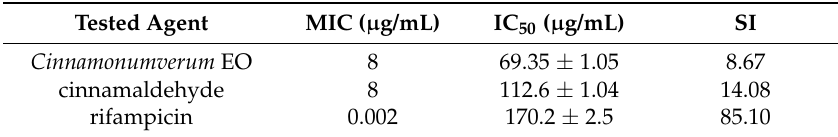
Table 2. IC 50 and SI values determined for Cinnamomumverum EO, cinnamaldehyde, and rifampicin as reference